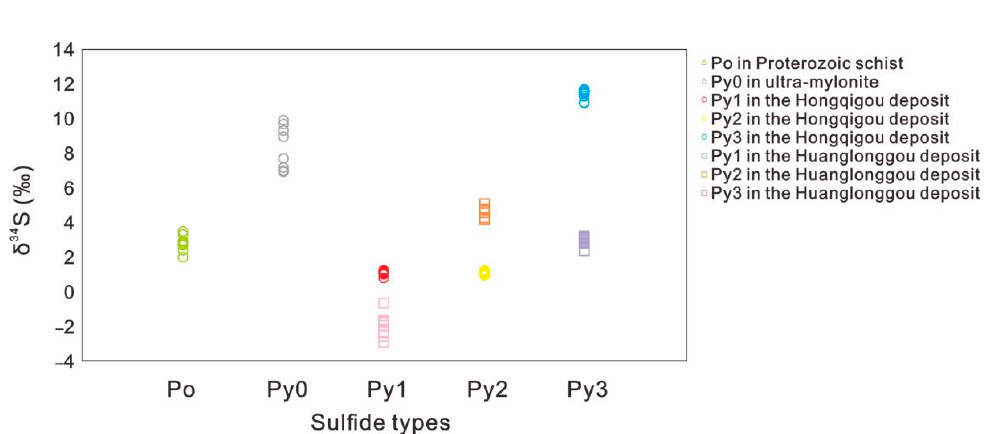
Figure 14. The δ 34 S values of pyrite from each stage of ores in the Hongqigou and Huanglonggou deposits, ultra-mylonite, and pyrrhotite in schist of wall rock.